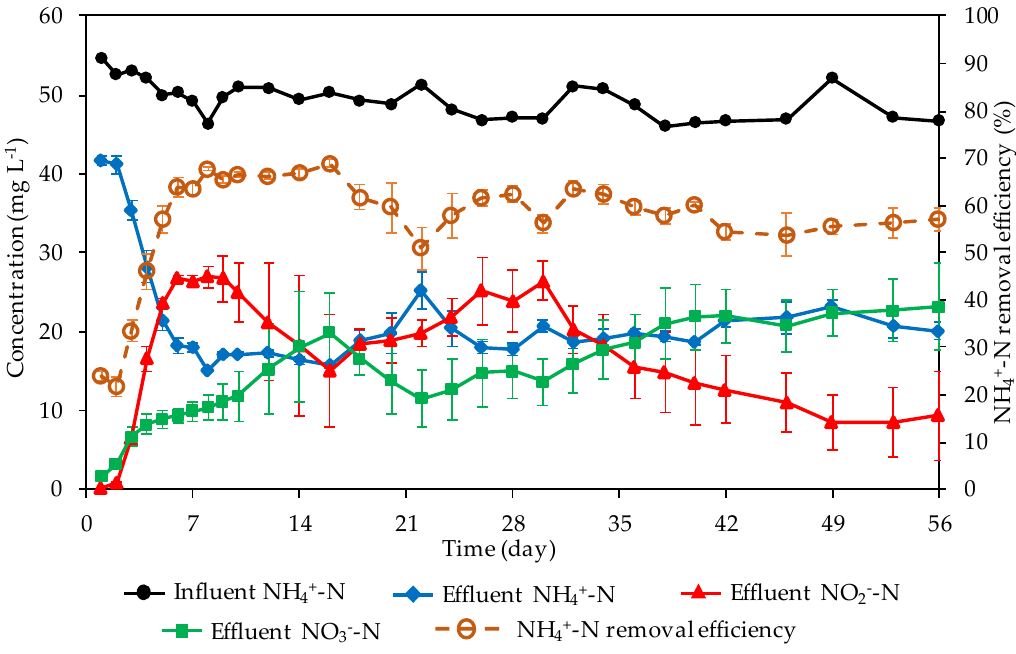
Figure 2. Changes in NH 4+ -N, NO 2‒ -N, and NO 3‒ -N concentration and NH 4+ -N removal efficiency over 56 days of operation. Values are means ± SD ( n = 4).